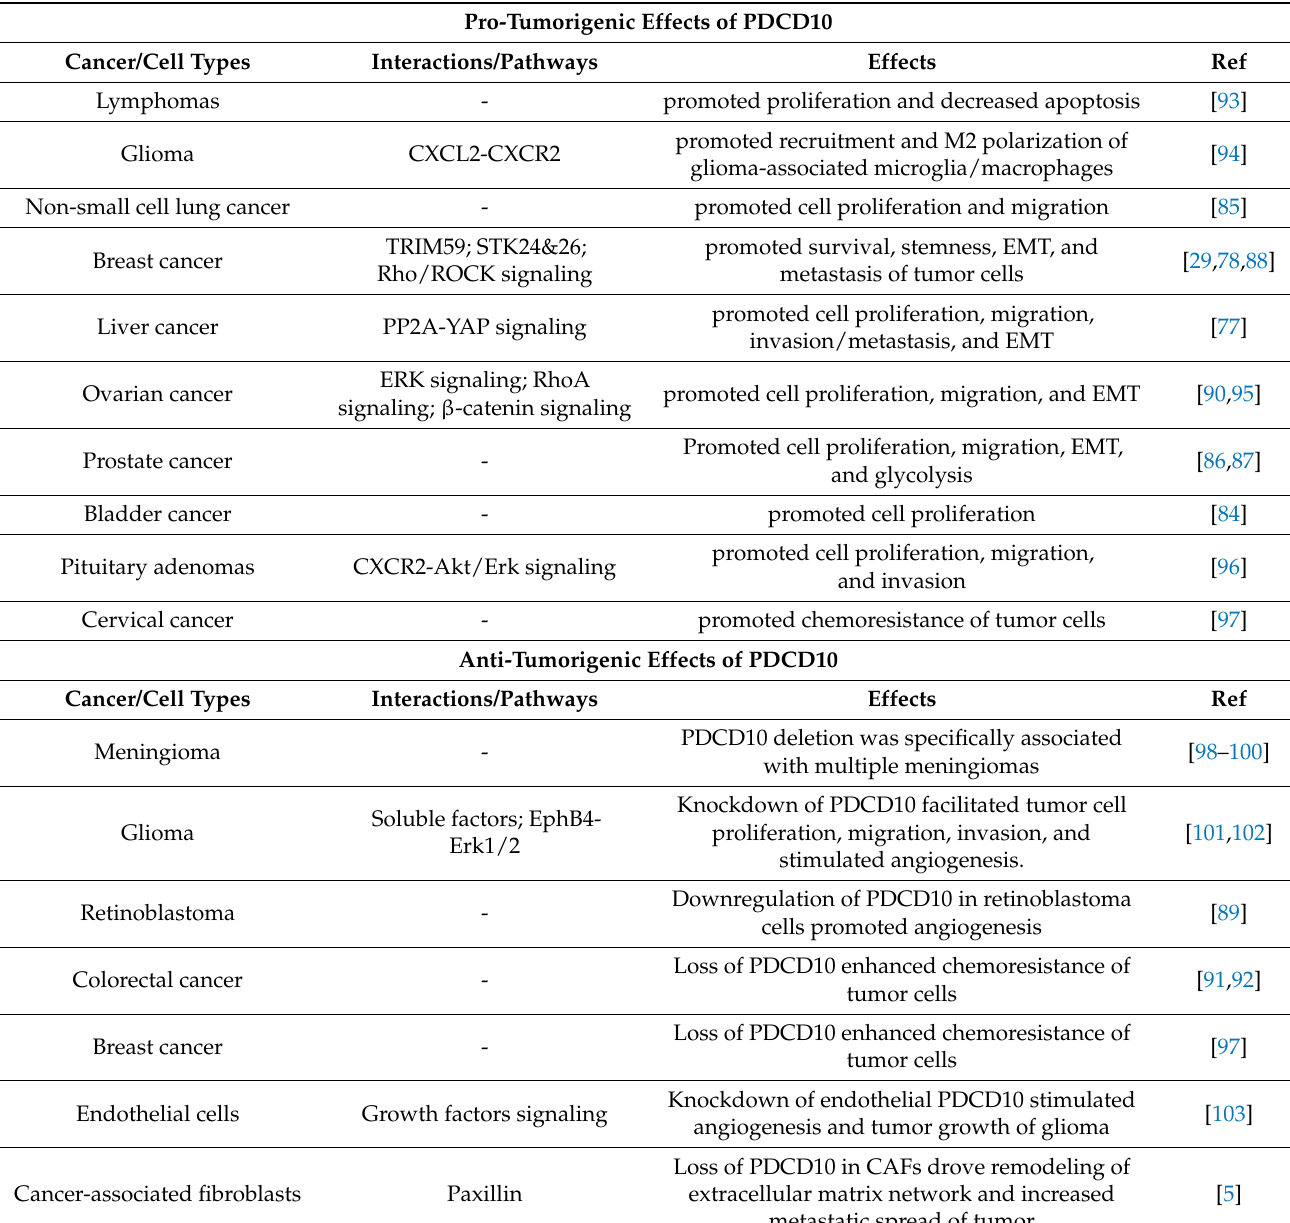
Table 2. The dual role (pro- or anti-tumor effects) of PDCD10 in cancers. Pro-Tumorigenic Effects of